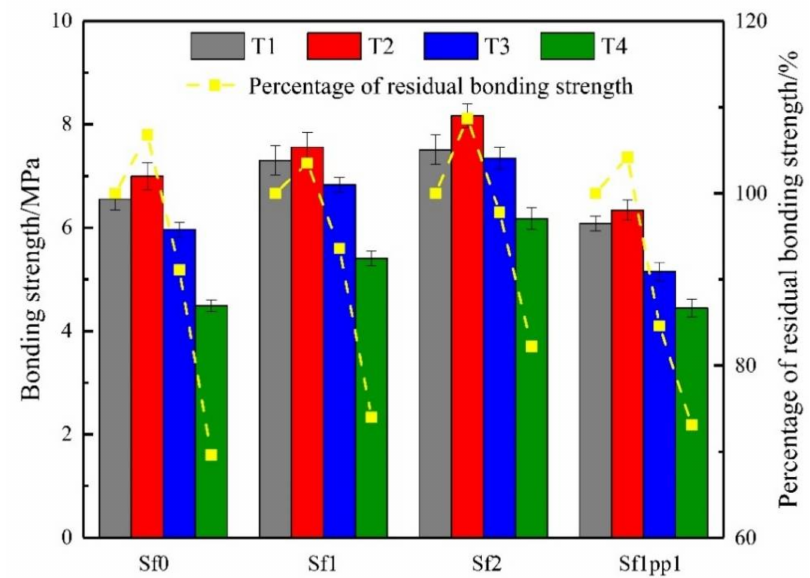
Figure 5. Evolution and residual percentage of bonding strength of the repaired systems under high